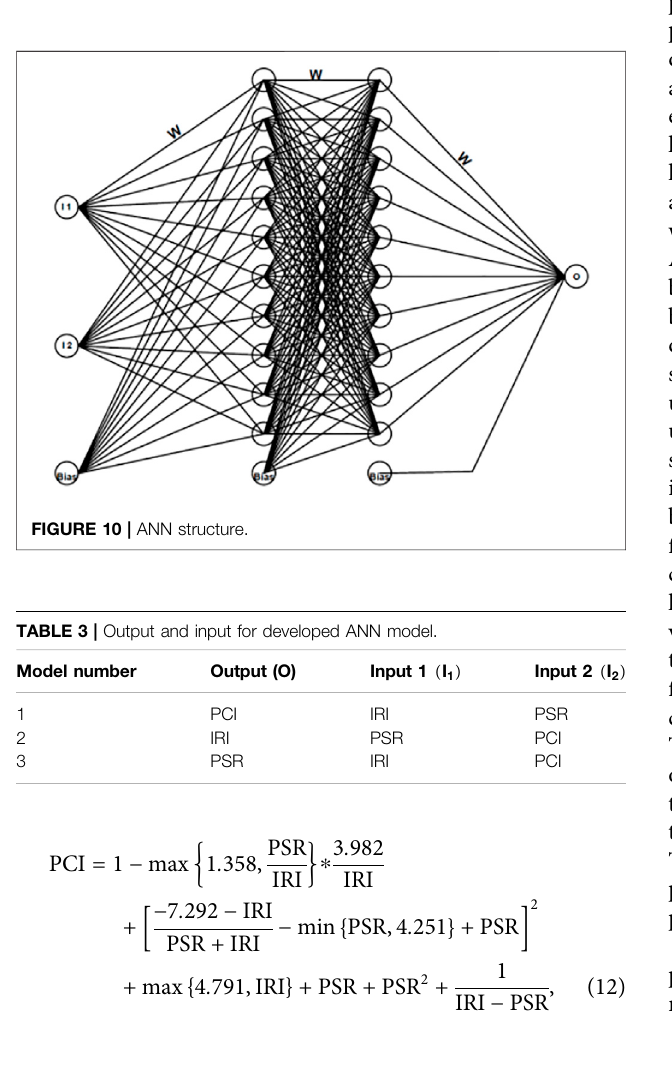
FIGURE 9 | Structure of backpropagation neural network.